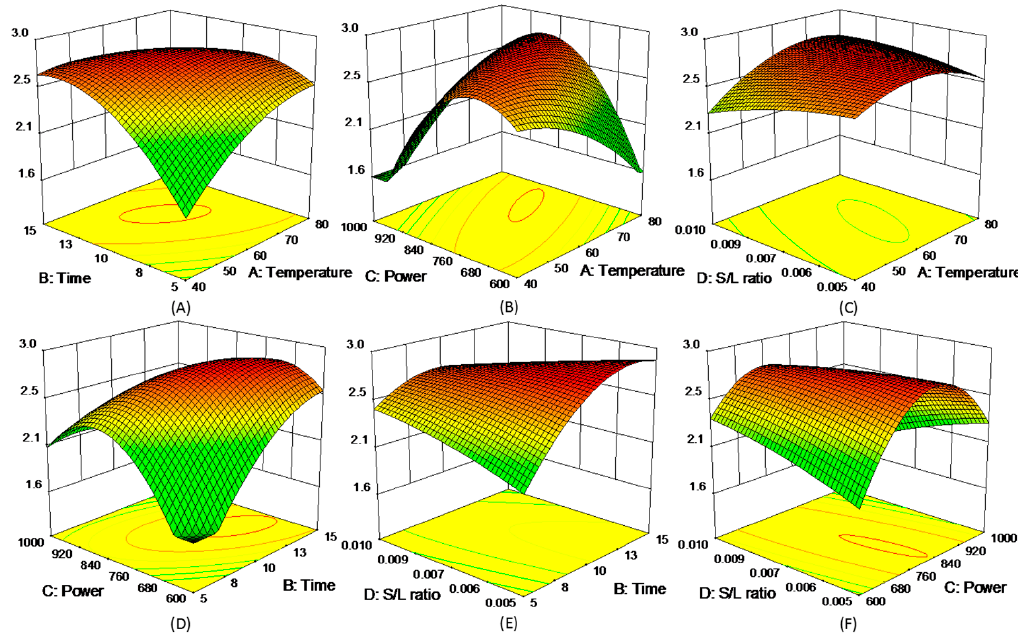
Figure 3. 3D response surface plots of ROS.